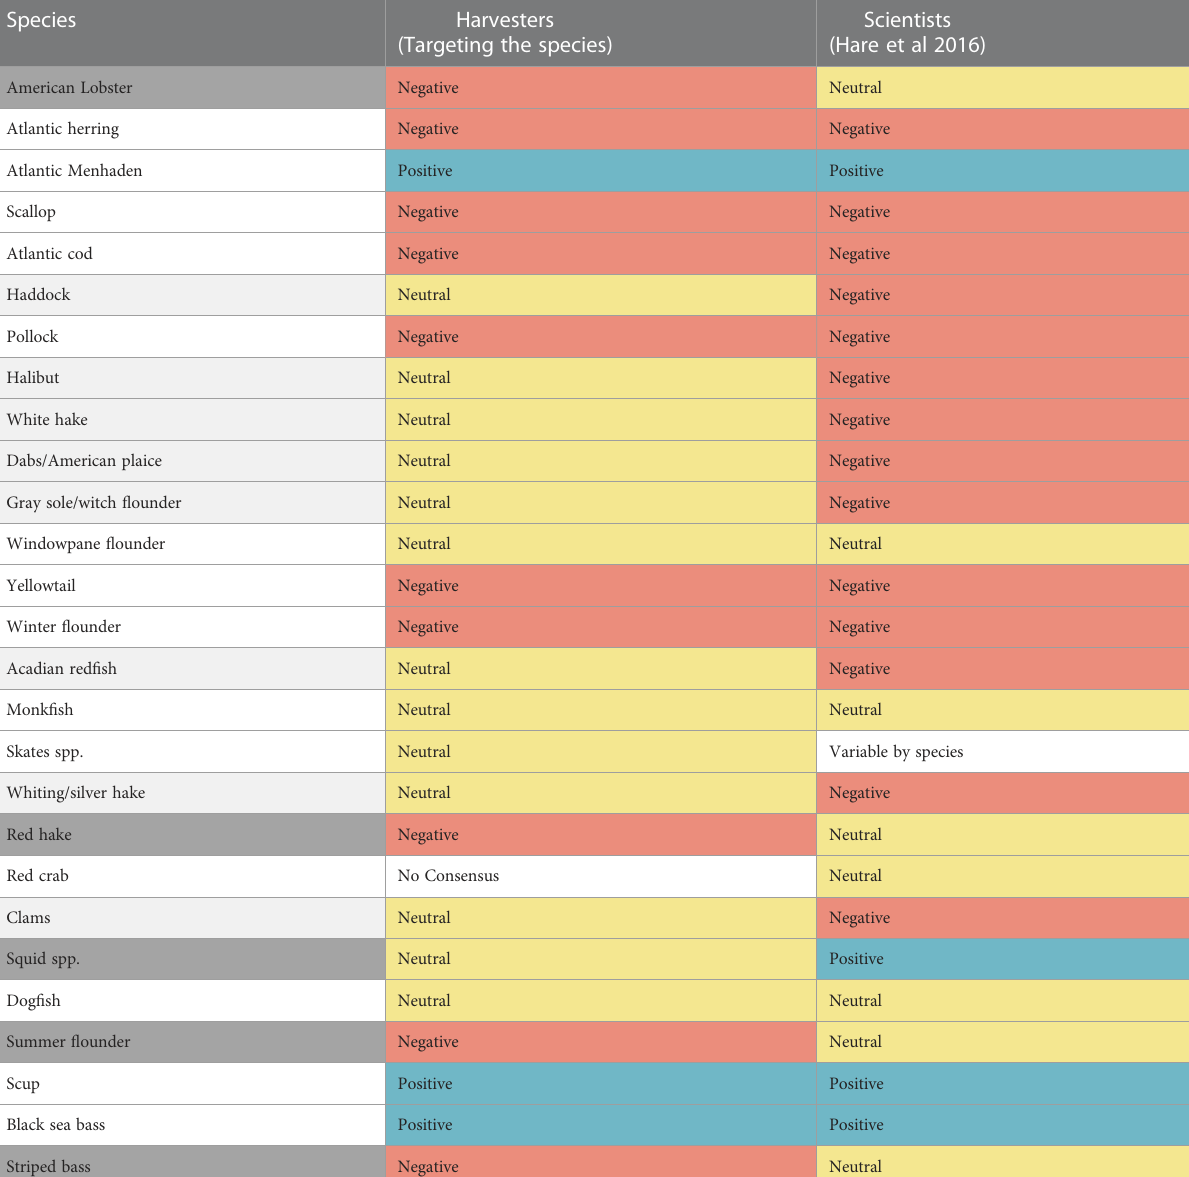
Red means negative impact of climate change, yellow means neutral or no impact, and blue means a positive impact. Species highlighted in grey indicate where there is disagreement between the two groups, with dark gray indicating harvesters perceiving a worse impact and light gray indicating scientists perceiving a worse